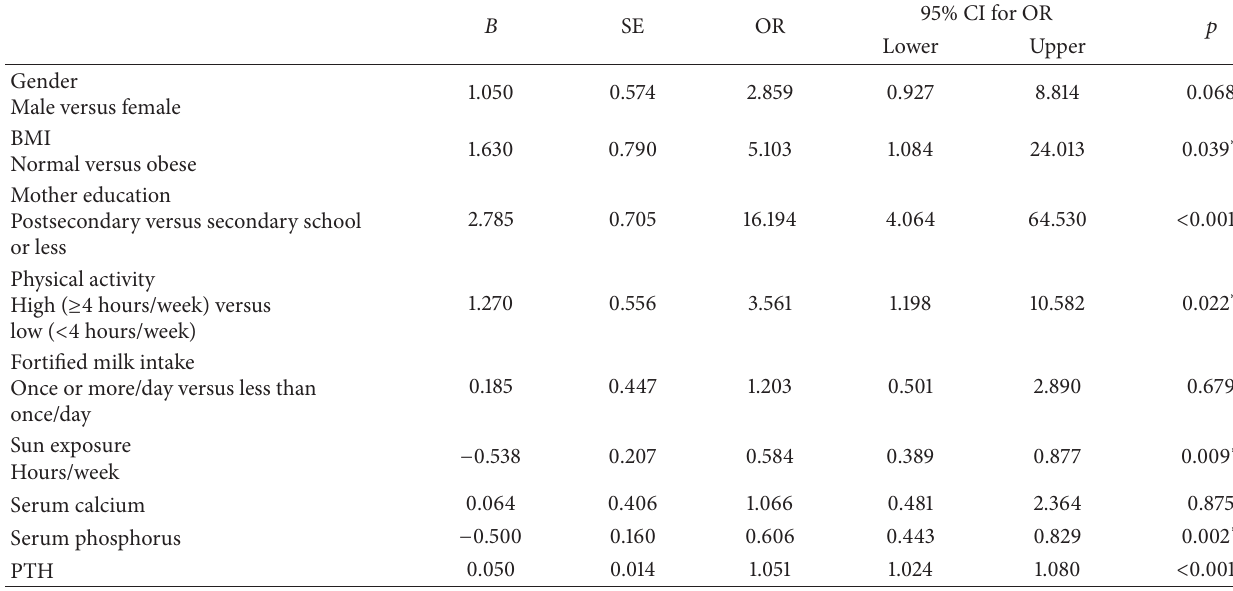
Table 4: Logistic regression for presumed risk factors for vitamin D insufficiency (25(OH)D 20–29.9 ng/mL). 𝐵 SE OR 95% CI for OR 𝑝 Lower